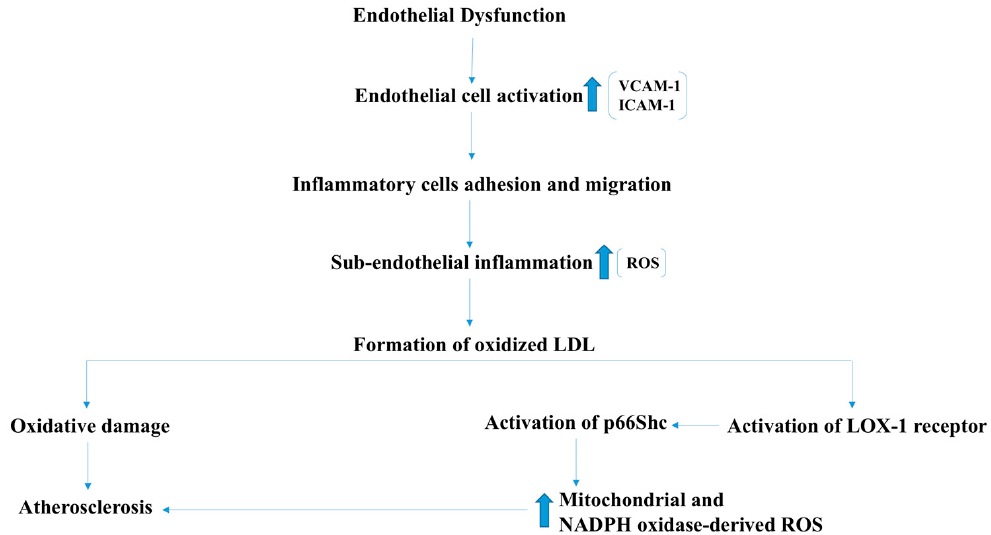
Figure 7. p66SHC plays crucial role in oxLDL-mediated oxidative damage to vascular endothelium through NADPH oxidase-derived and mitochondrial ROS. Initial damages to endothelium induces EC activation (vascular cell adhesion molecule-1 (VCAM1), intercellular adhesion molecule-1 (ICAM1) induction) and adhesion of inflammatory cells to EC resulting in ROS production. Inflammatory cell migration to sub-endothelial layer results in “foam call” formation. oxLDL-induced atherosclerotic changes involve inflammatory cells, activation of p66SHC and ROS from mitochondria and NADPH